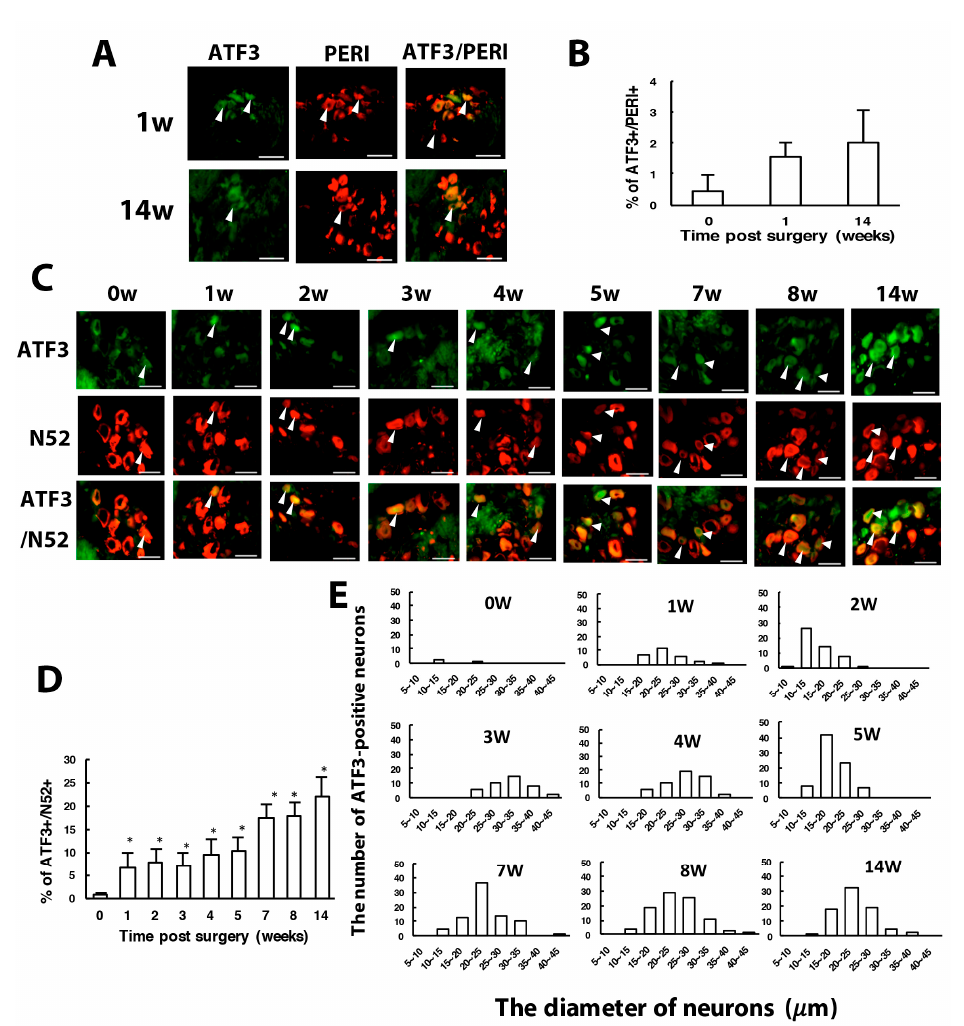
Figure 4. The number of ATF3-positive neurons is increased with time after CCI surgery. Ipsilateral L5 DRG were excised at 0, 1, 2, 3, 4, 8, 14 w after CCI surgery and co-stained with anti-ATF3 and anti-PERI antibodies ( A , B ) or anti-ATF3 and anti-N52 antibodies ( C – E ). ( A ) Neuron images showing green fluorescence for ATF3-positive (ATF3 + ) cells and red for PERI-positive (PERI + ) cells. Arrowheads indicate ATF3 + /PERI + neurons. Scale bar is 50 μ m. ( B ) Percentage of ATF3 + /PERI + neurons among PERI + neurons (0 w, n = 3310; 1 w, n = 1107; 14 w, n = 637 PERI+ neurons). ( C ) Neuron images show green fluorescence for ATF3 + cells and red for N52-positive (N52 + ) cells. Arrowheads are ATF3 + /N52 + neurons. Scale bar is 50 μ m. ( D ) Percentage of ATF3 + /N52 + neurons among N52 + neurons. Each time point contains n = 358-771 N52 + neurons. * p < 0.05. ( E ) Number of ATF3 + /N52 + neurons in neuron groups of different diameters. 0 w, n = 3; 1 w, n = 26; 2 w, n = 50; 3 w, n = 41; 4 w, n = 51; 5 w, n = 80; 7 w, n = 79; 8 w, n = 92; 14 w, n = 79 ATF3 + /N52 + neurons. n = 2 mice.